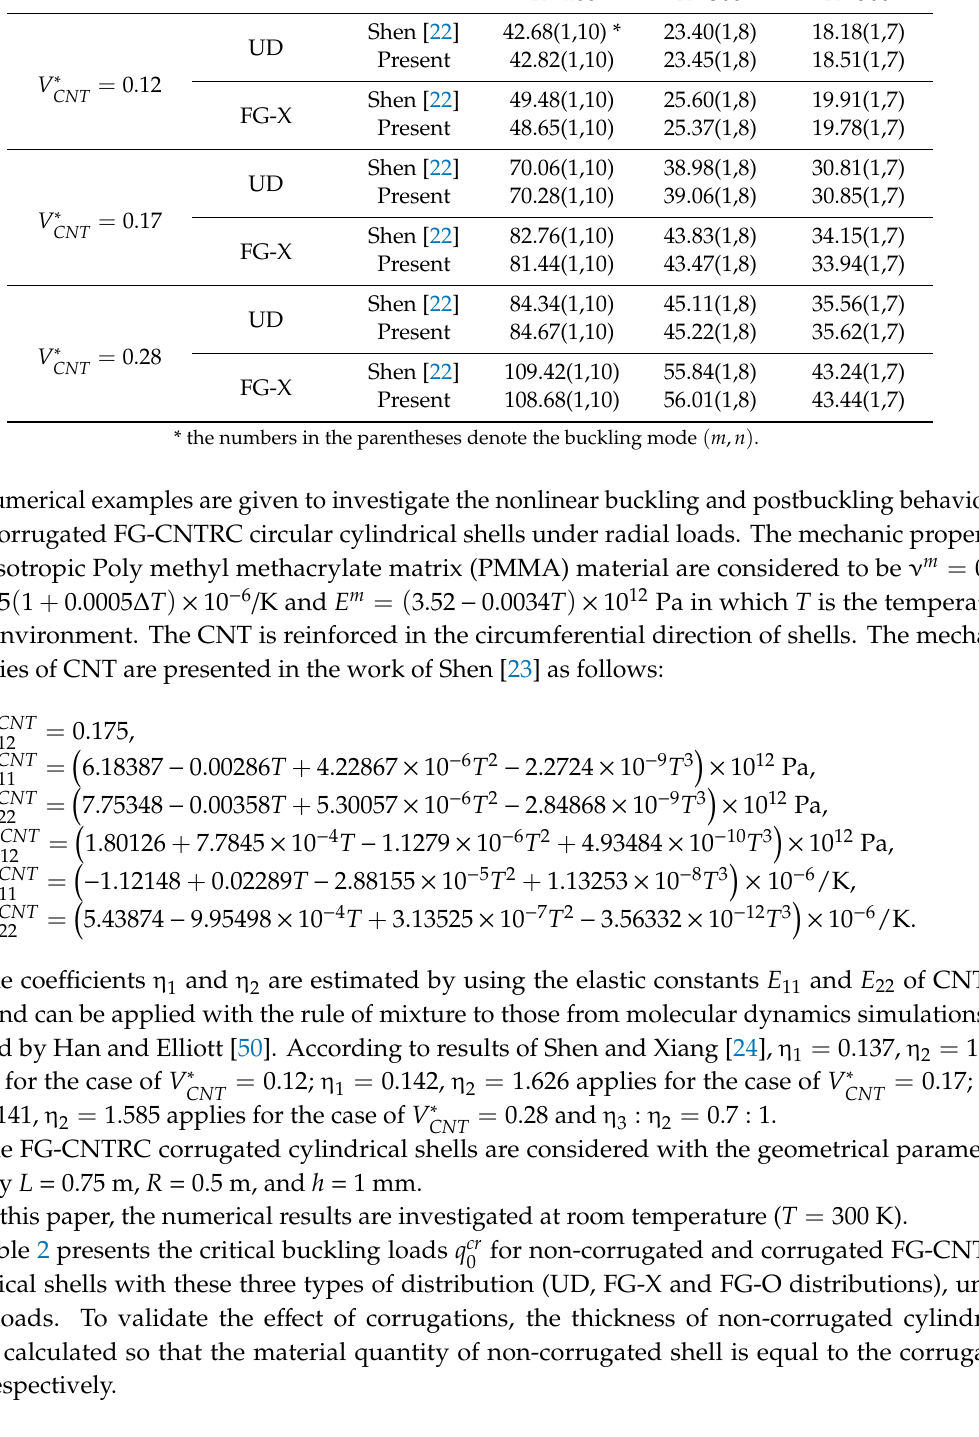
Table 1. Comparisons of critical buckling loads of non-corrugated FG-CNTRC cylindrical shells subjected to radial loads (in kPa) ( h = 0.001 m, R / h = 100, T = 300 K, Z = L 2